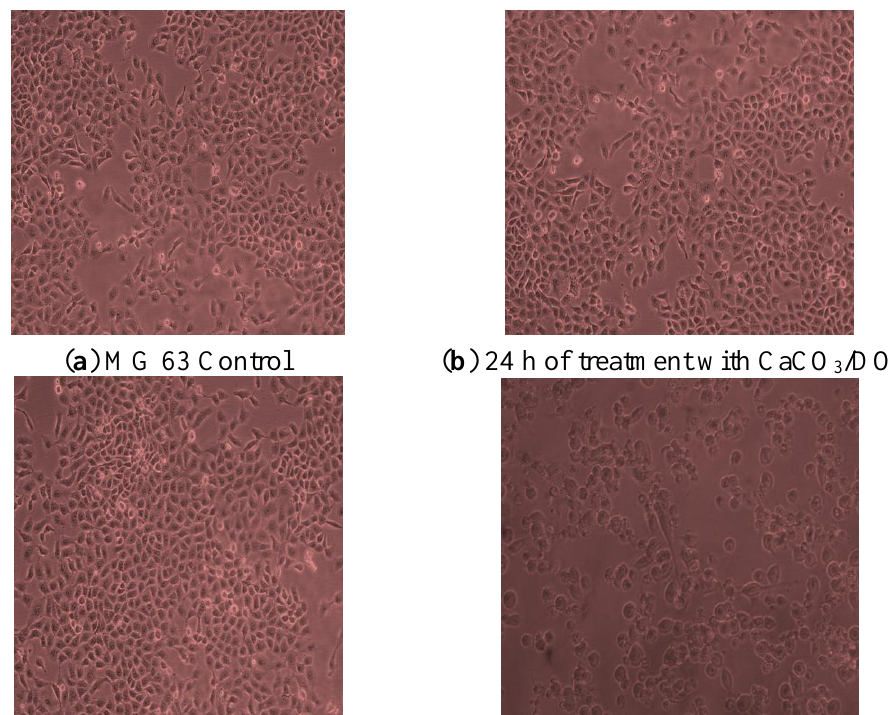
Figure 9. Image of MG 63 cells treated with various for 24, 48 and 72h of incubation